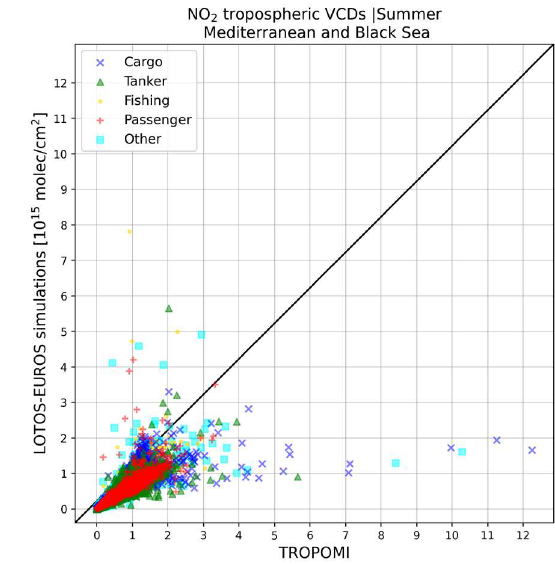
Figure 9. Tropospheric NO 2 vertical column densities (in 10 15 molecules cm −2 ) seasonal variability according to the 2019 vessel density for the Mediterranean and Black Sea regions: ( a ) TROPOMI; ( b ) LOTOS-EUROS.